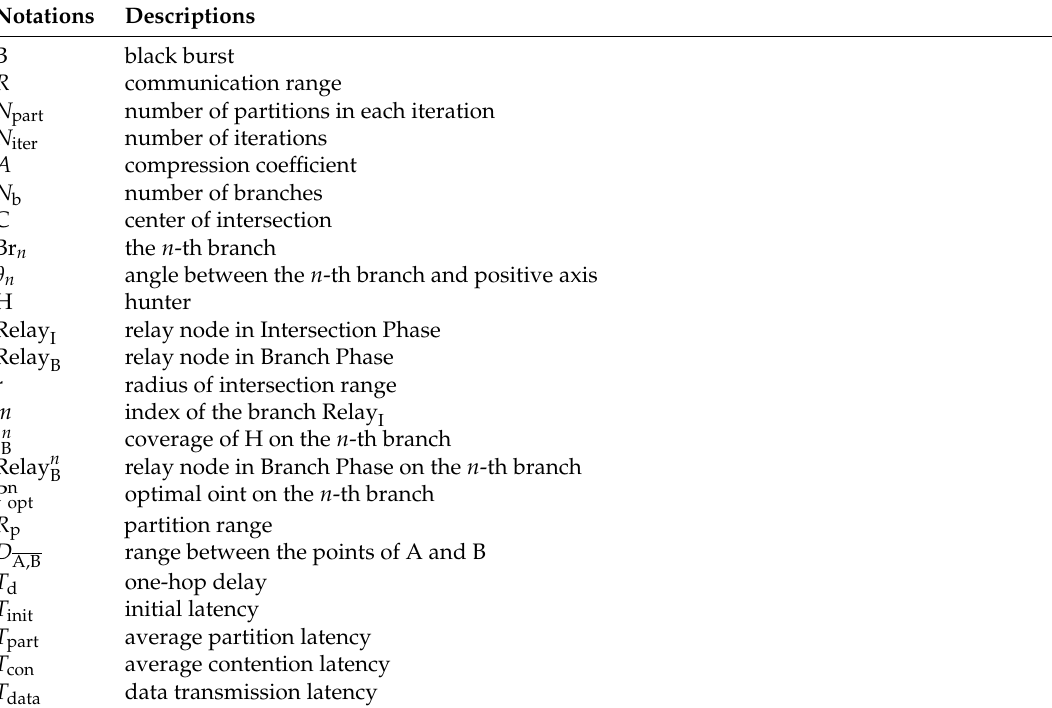
Table 1. Summary of